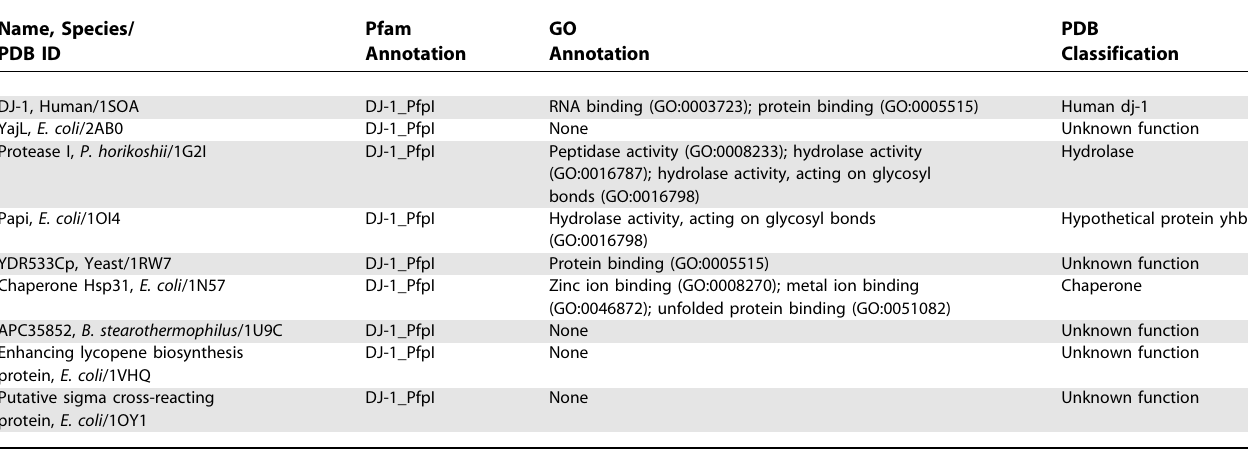
Table 1. Annotations for the DJ-1 Superfamily Members, as Given by Pfam, GO, and the PDB Name, Species/ PDB